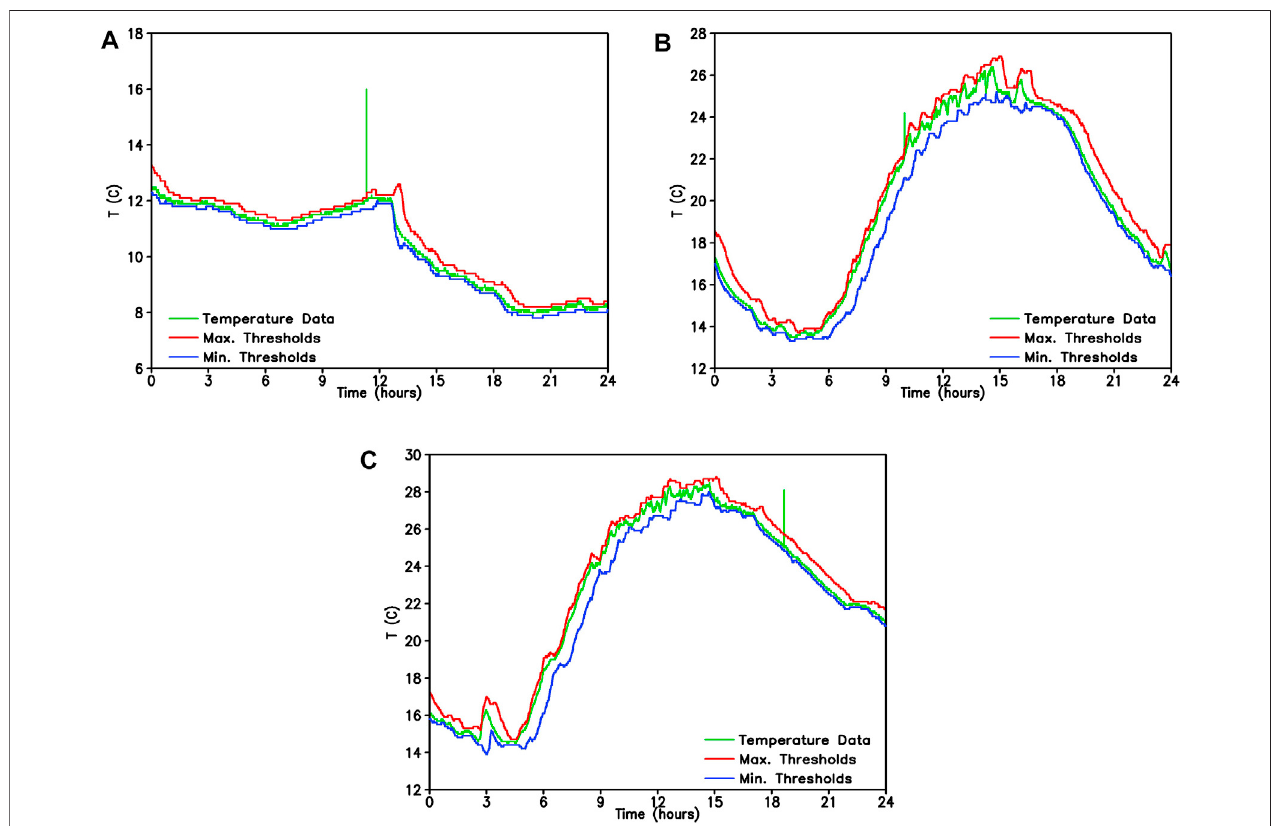
FIGURE 3 | Same as in Figure 1 , but for scheme 7 (Unit: ° C) at SA station on 1 May, 9 May, and 26 May, 2016.